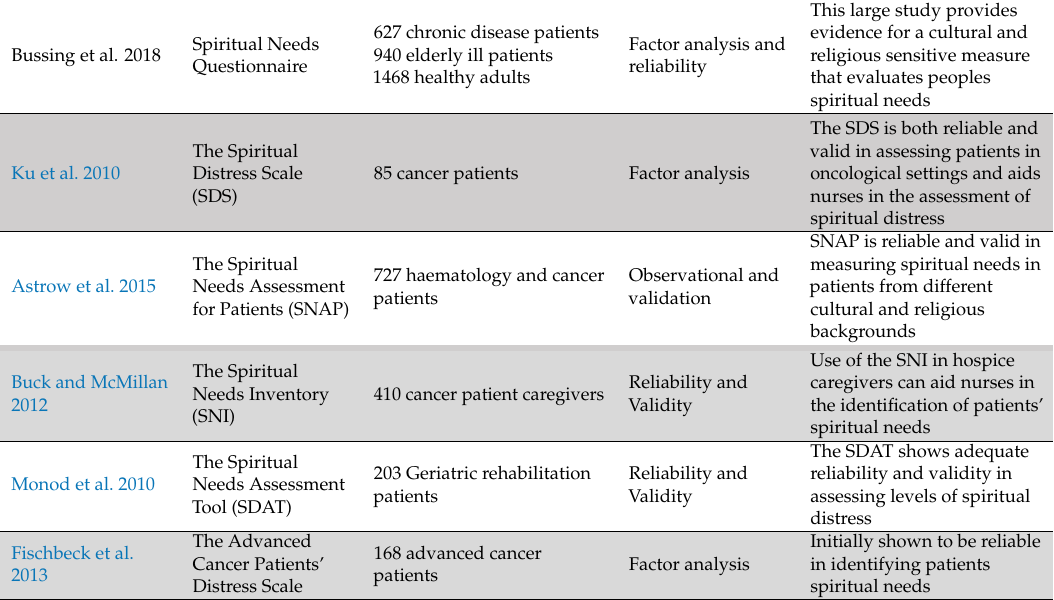
Table 3. Spiritual needs and spiritual distress measures used in clinical